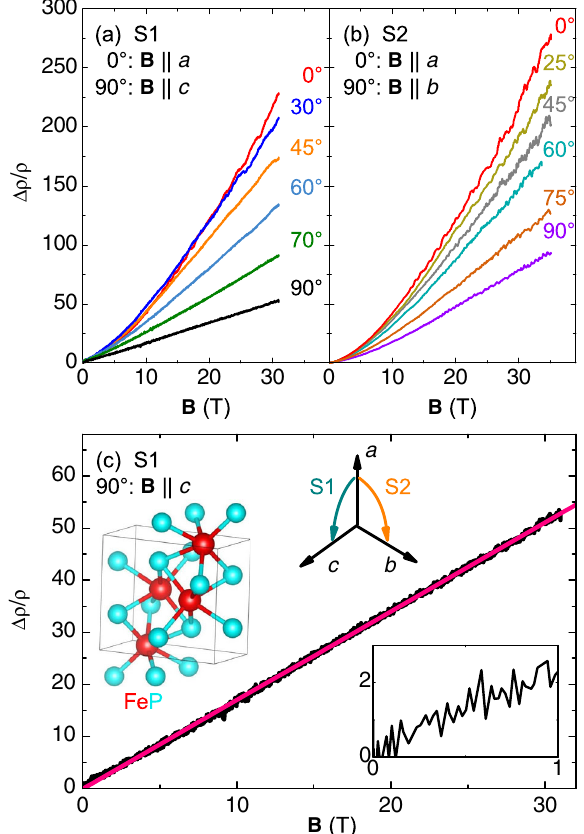
Fig. 2 Magnetoresistance of FeP at high fi eld. The transverse MR fi elds Δ ρ / ρ , de fi ned as ρ ð B Þ(cid:2) ρ ð 0T Þ ρ ð 0T Þ , measured up to high magnetic oriented at several angles for FeP crystals a S1 (RRR ≈ 1300) and b S2 (RRR ≈ 1400), whose orientations are noted. Note that S1 was actually aligned with two different re fl ections of the [101] family, but the angle has been shifted to ease readability. The temperature was held constant at 400 ± 50 mK for all measurements. MR is larger for S2 at the common B ∥ a -axis orientation, which can be linked to its higher RRR value. c The B ∥ c -axis data for S1, with a linear fi t (pink) made over the entire fi eld range. The graphics above the curve show an image of the unit cell highlighting the octahedral Fe – P coordination, and axes that indicate the alignment of the crystal picture (generated with VESTA 59 ) and how fi eld was rotated for S1 and S2 (current was always perpendicular to fi eld). The inset below the curve is a closeup of the data below 1